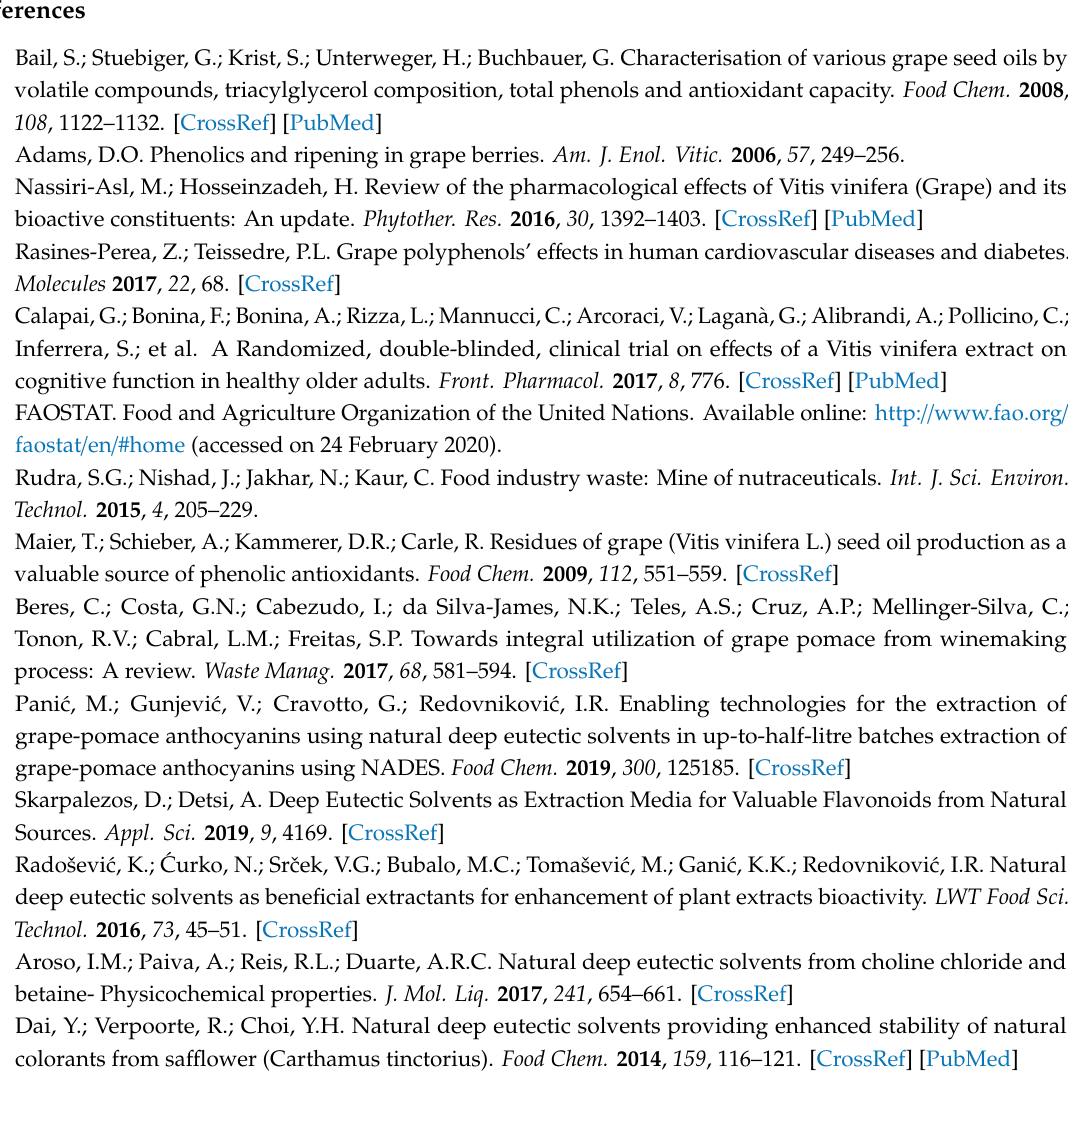
Table S1: Antioxidant activity of grape seed extracts, Table S2: Antioxidant activity of grape skin extracts, Figure S1: HPLC chromatogram of polyphenols in a sample of grape seeds, Figure S2: HPLC chromatogram of polyphenols in a sample of grape